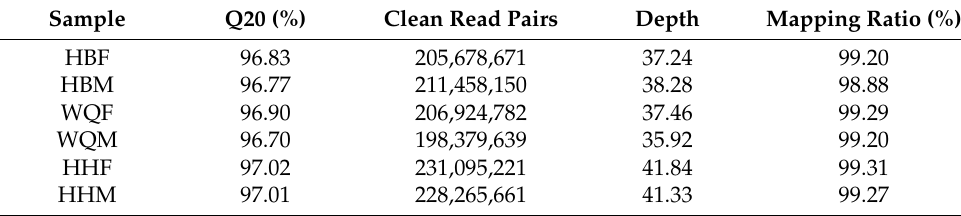
Table 1. Summary of genome sequencing and